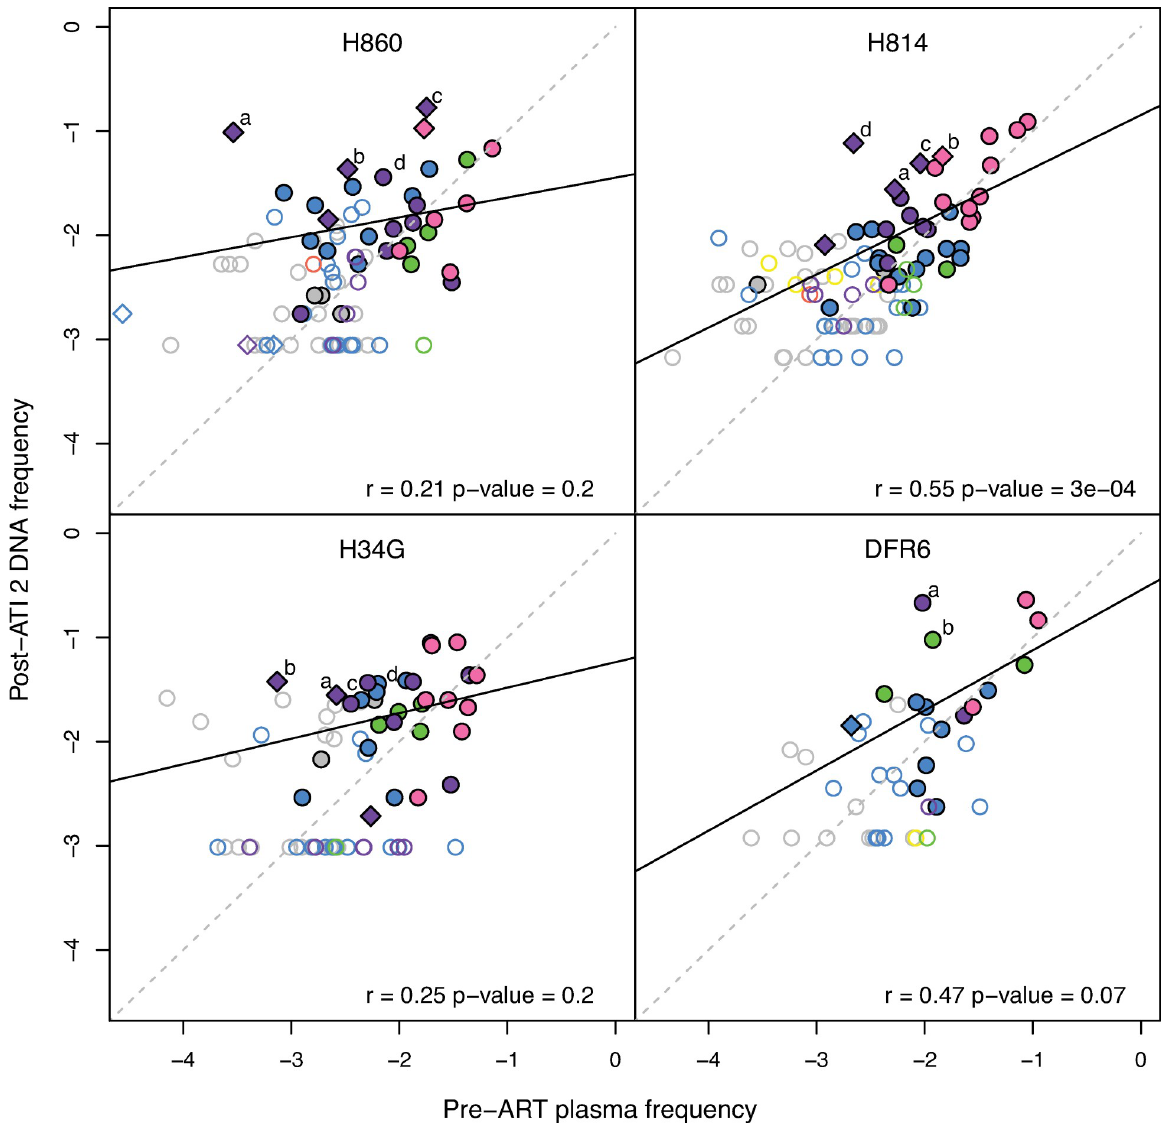
Fig 6. Changes to the composition of the PBMC CA-vDNA population. The estimated average DNA frequencies of all barcodes in post-ATI-2 on-ART samples compared to their relative frequencies in pre-ART plasma. The open symbols designate barcodes detected only at a single time point. The diamonds highlight barcodes that replicated at least 10-fold more in ATI-2 than pre-ART. The color coding designates which ATIs the barcodes were detected in: no ATI (grey), ATI-1 only (yellow), ATI-2 only (blue), ATI-3 only (red), ATI-1 and ATI-2 (green), ATI-2 and ATI-3 (purple), all ATIs (pink). The dark solid lines depict the linear regressions, while the grey dashed lines represent theoretical one-to-one correspondence.